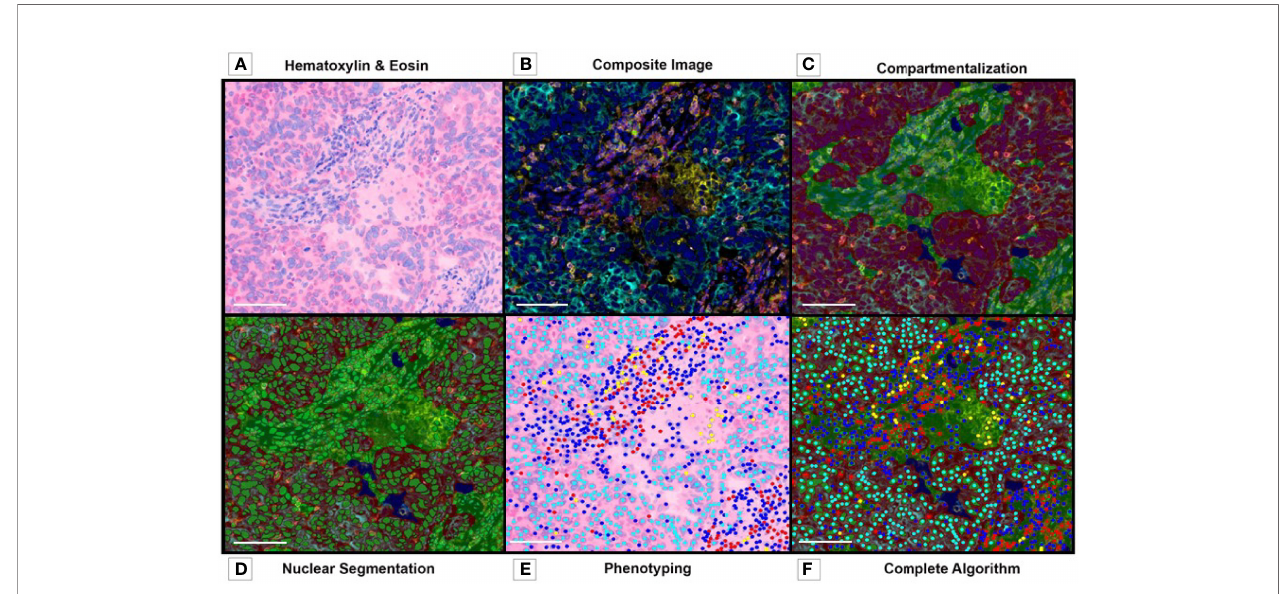
FIGURE 8 | Multiplex Immuno fl uorescence. Image Analysis Overview. (A) Tumor and Stroma H&E image before preparation with multiplex fl uorochromes. (B) Composite image, before algorithm analysis. (C) Tissue compartmentalization, tumor (red), stroma (green). (D) Nuclear detection and nuclear segmentation in both compartments (tumor and stroma). (E) Phenotyping map. (F) Complete algorithm visualization, including tissue segmentation, nuclear detection, cell segmentation and phenotyping. Composite image from inForm ® image analysis software, Akoya bioscience (scale bar: 100 m m). Scanner Vectra